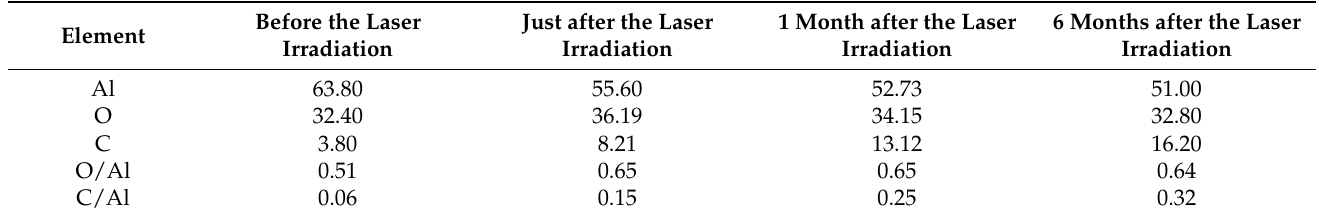
Table 1. EDS-measured chemical composition of the aluminum surface before and after the single- shot laser processing with the pulse energy of 192 mJ.